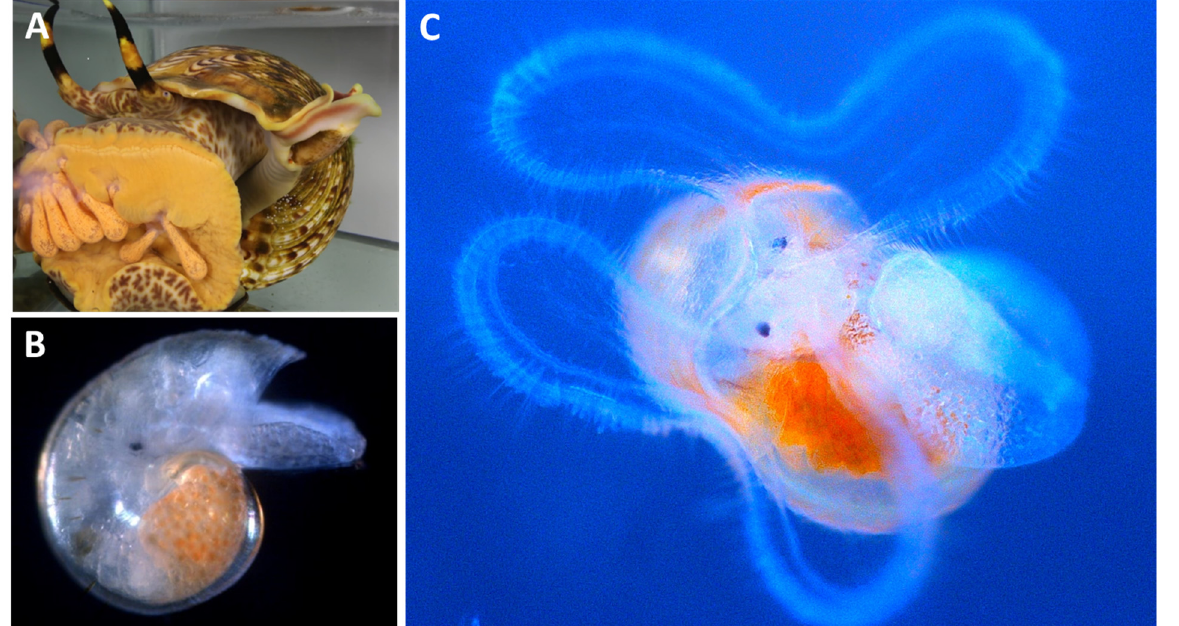
Figure 2. The early life history stages of Charonia tritonis . ( A ) Adult female depositing egg capsules in the SeaSim laboratory at AIMS (Photo: Peter Thomas-Hall, AIMS), ( B ) side profile of 25-day post fertilization veliger showing yolk reserve (orange) and eye spot (black) (Photo: Tom Barker, AIMS) and ( C ) front view of 14-day post hatched veliger with two eye spots visible and velum extended (Photo: Thomas Armstrong, AIMS).